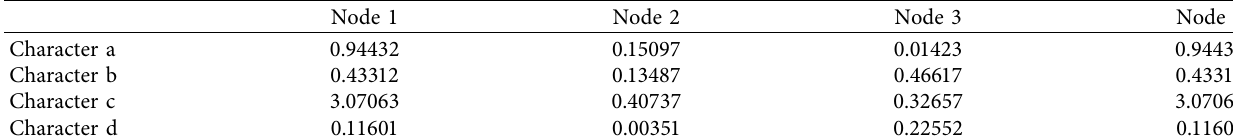
Table 1: Inspection standards for model performance.